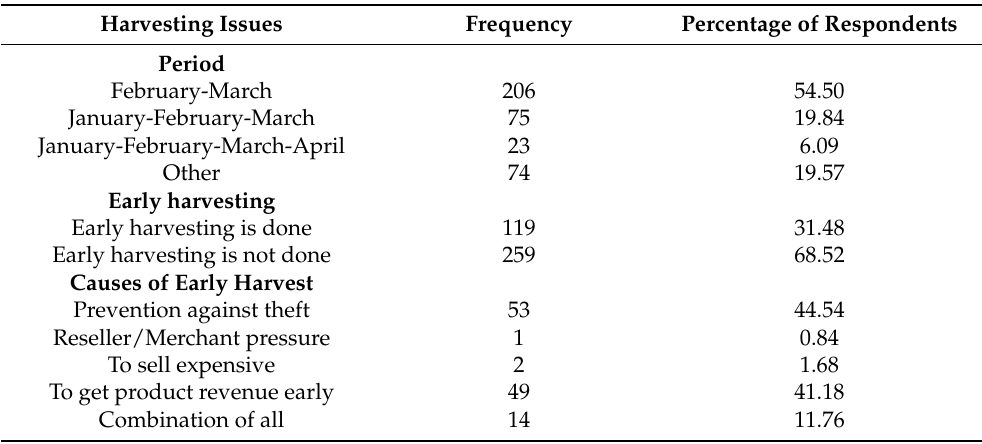
Table 5. Opinions of farmers concerning harvesting